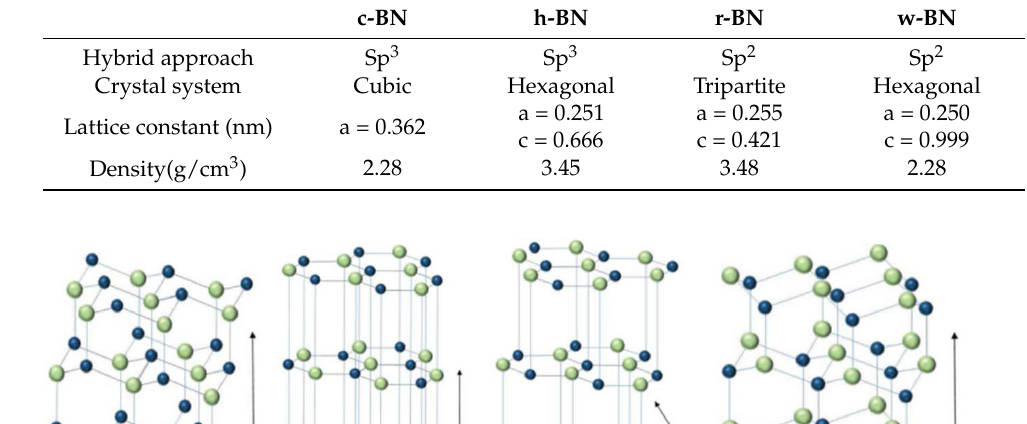
Table 1. Main isomer parameters of BN.